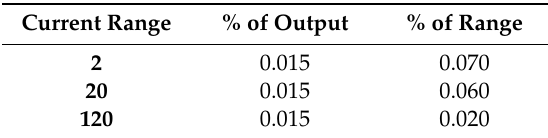
Table 3. Main features of the two transconductance 52120A.